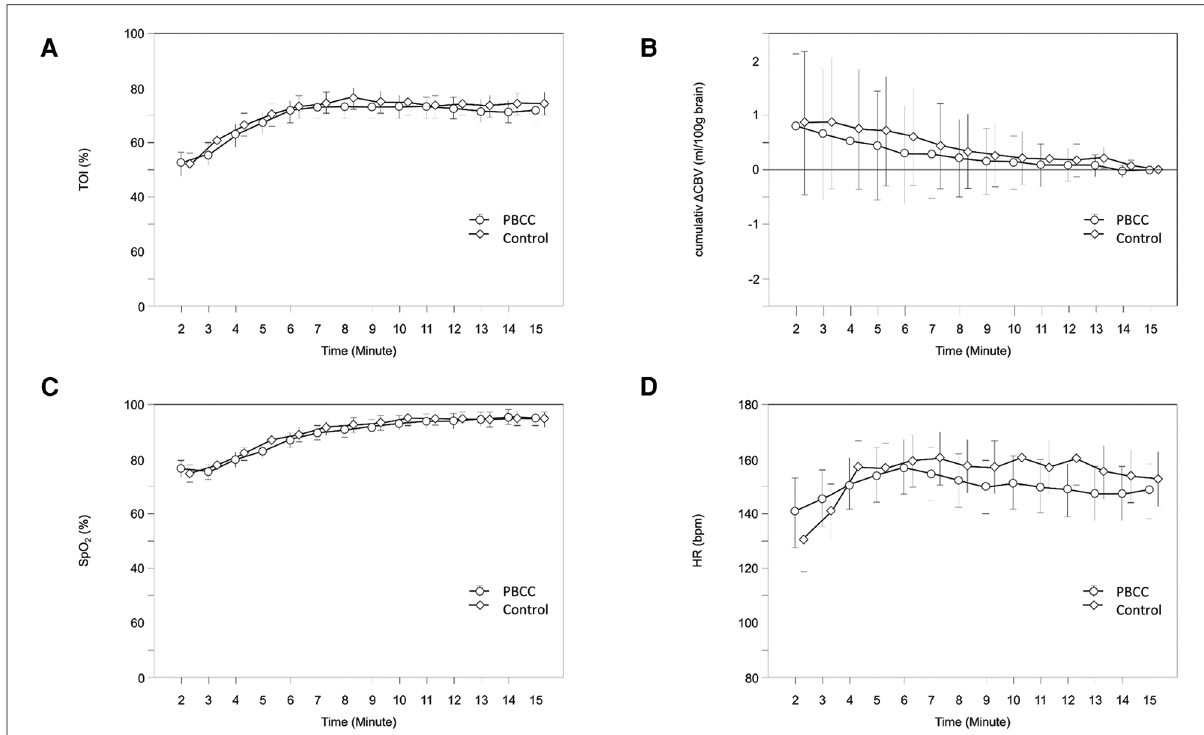
FIGURE 2 Courses of cTOI ( A ), Δ CBV ( B ), SpO2 ( C ) and HR ( D ) within the fi rst 15 min after birth in PBCC (circles) and control group (diamonds); values are mean (95% CI). CBV, cerebral blood volume; cTOI, cerebral tissue oxygenation; HR, heart rate; SpO2, peripheral arterial oxygen saturation.